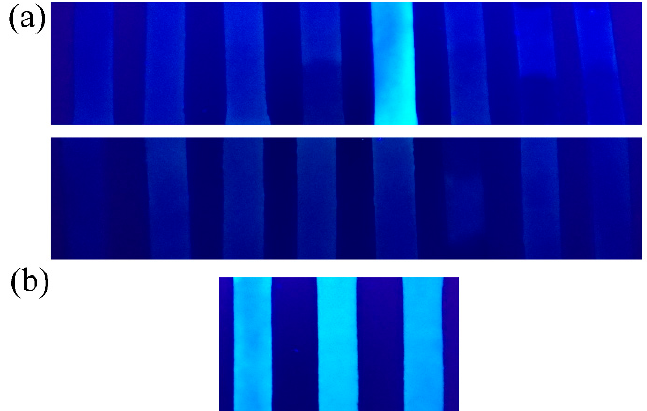
Figure 8. Photographs of test strips under a 365 nm UV lamp: ( a ) after being dipped into aqueous solutions of different metal ions (100 µ M) (from left to right, up: Ba 2+ , Ce 3+ , Cd 2+ , Co 2+ , Al 3+ , Cr 3+ , Cu 2+ and Fe 3+ ; down: Hg 2+ , In 3+ , K + , Mn 2+ , Na + , Ni 2+ , Pb 2+ and Zn 2+ ); ( b ) after being dipped into different solutions of Al 3+ (100 µ M) (from left to right: deionized water, tap water and river water).